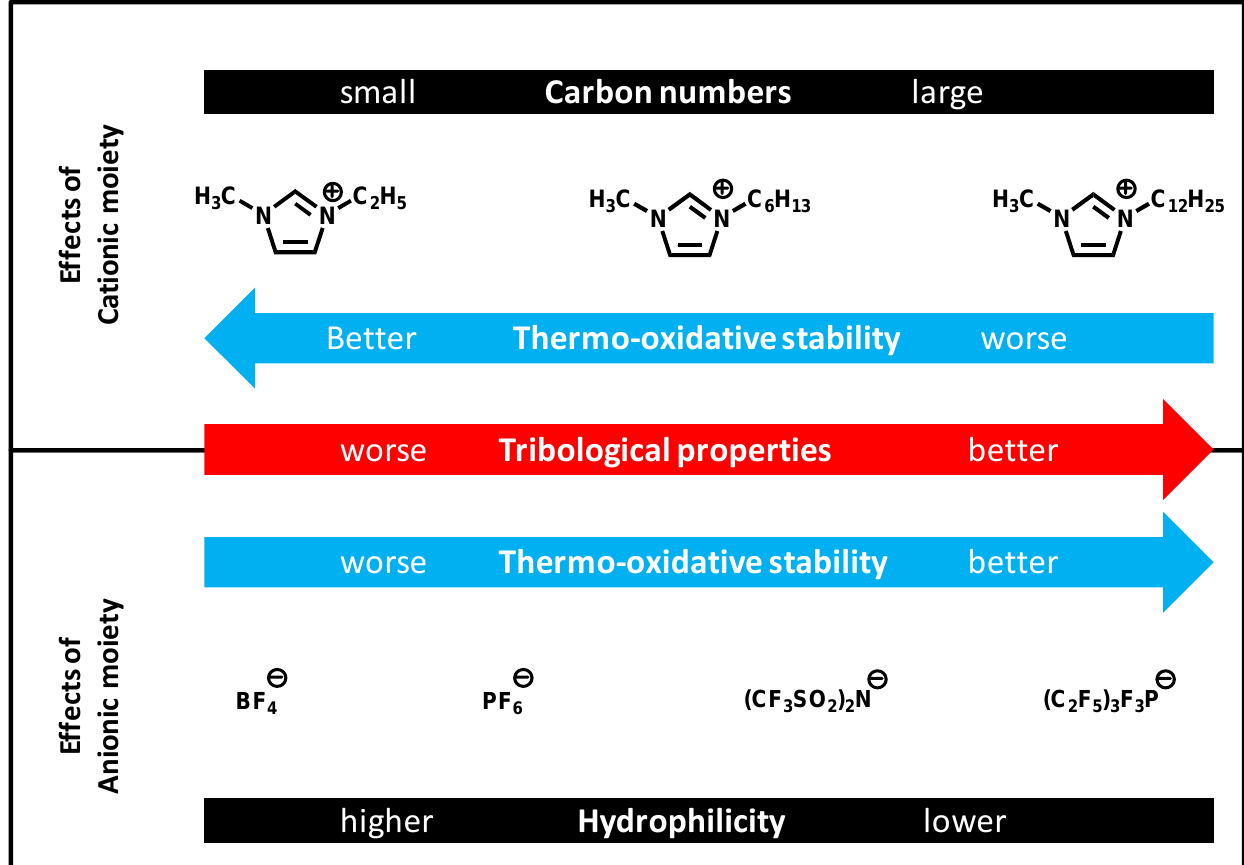
Figure 16. The relation between structure and lubricant